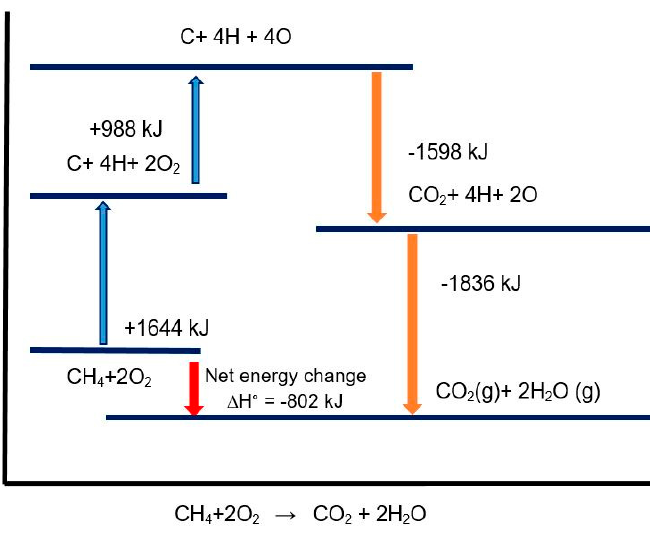
Figure 7. Schematic illustration of the combustion energy contained in methane.